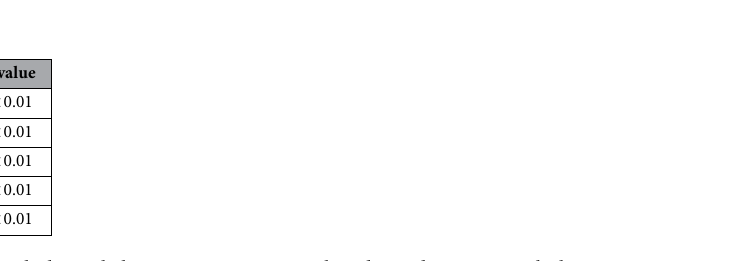
Table 2. Statistical tests of morphological characters. ANOVA on basidia and spore